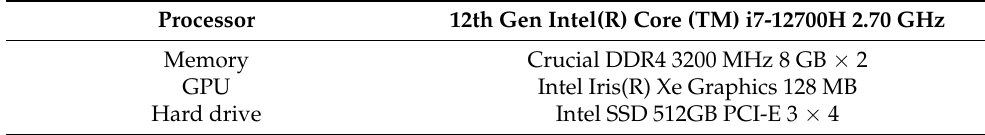
Table 5. Technical specifications of the computational platform.